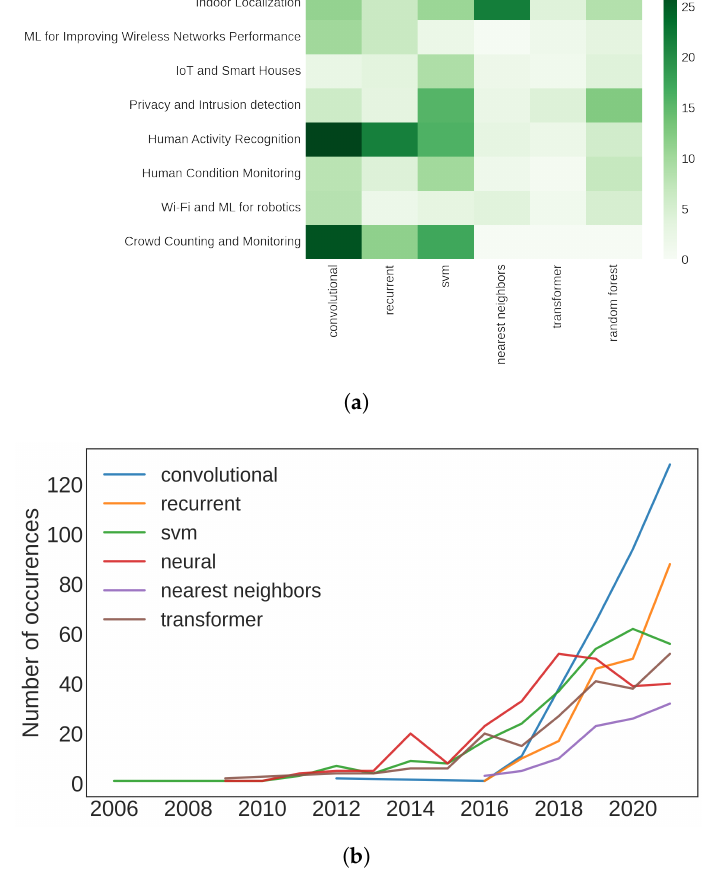
Figure 8. Graphs representing the Machine Learning models counts grouped by topics ( a ) and years ( b ). The term “Neural Network” is not present in order to have more comparable values. ( a ) Heatmap of the occurrences of ML models. ( b ) Word hits of the different ML algorithms over the years.